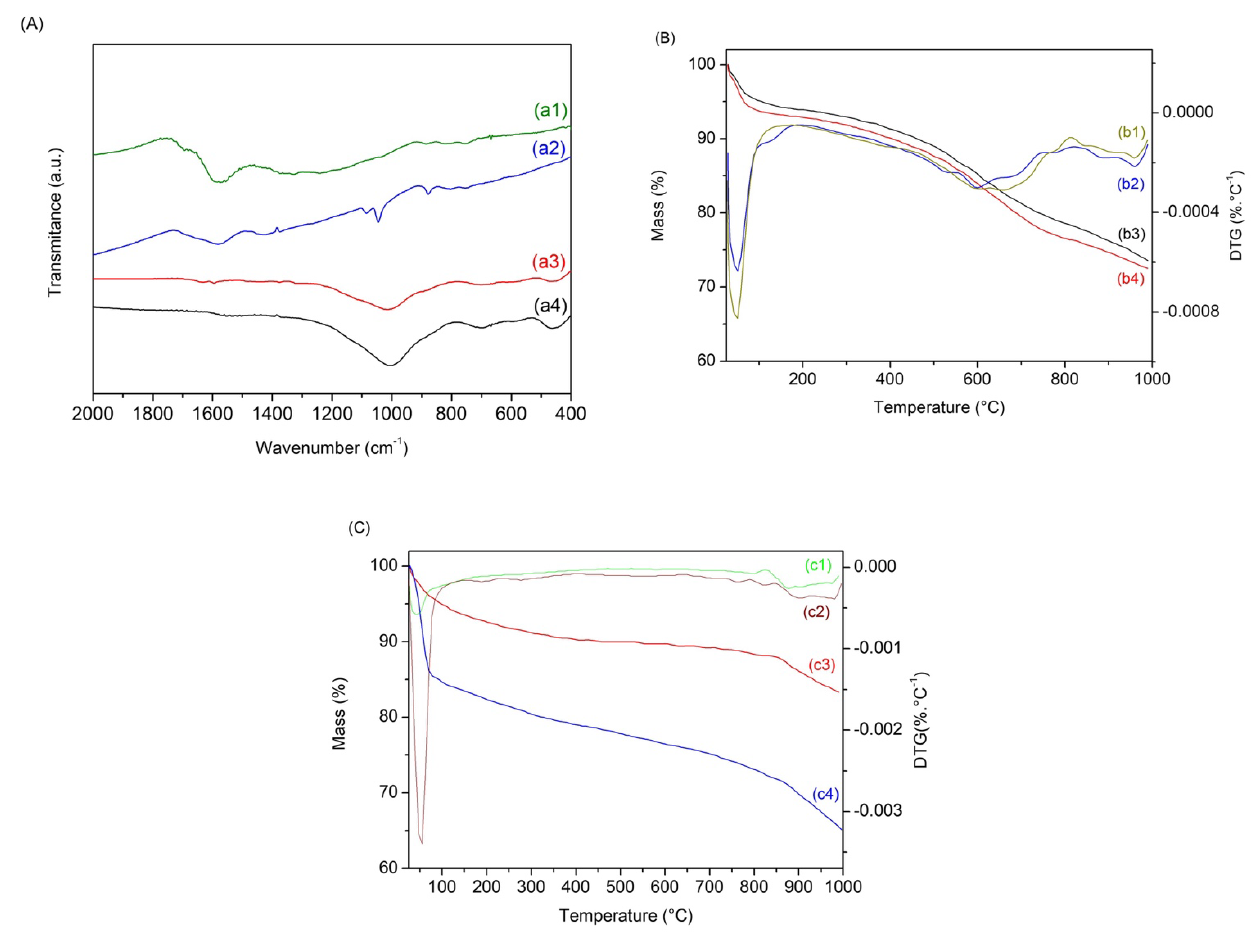
Figure 5. FTIR ( A ) for the studied biochar BE (a2), ABE (a1), BE (a4), and ABE (a3); TG ( B ) curves for the studied samples of biochar BE (b3), ABE (b4) and DTG ( B ) of biochar BE (b2) and ABE (b1) samples; TG ( C ) curves for the studied biochar samples BE (c3), ABE (c4), and DTG ( C ) of biochar samples BE (c1) and ABE (c2).